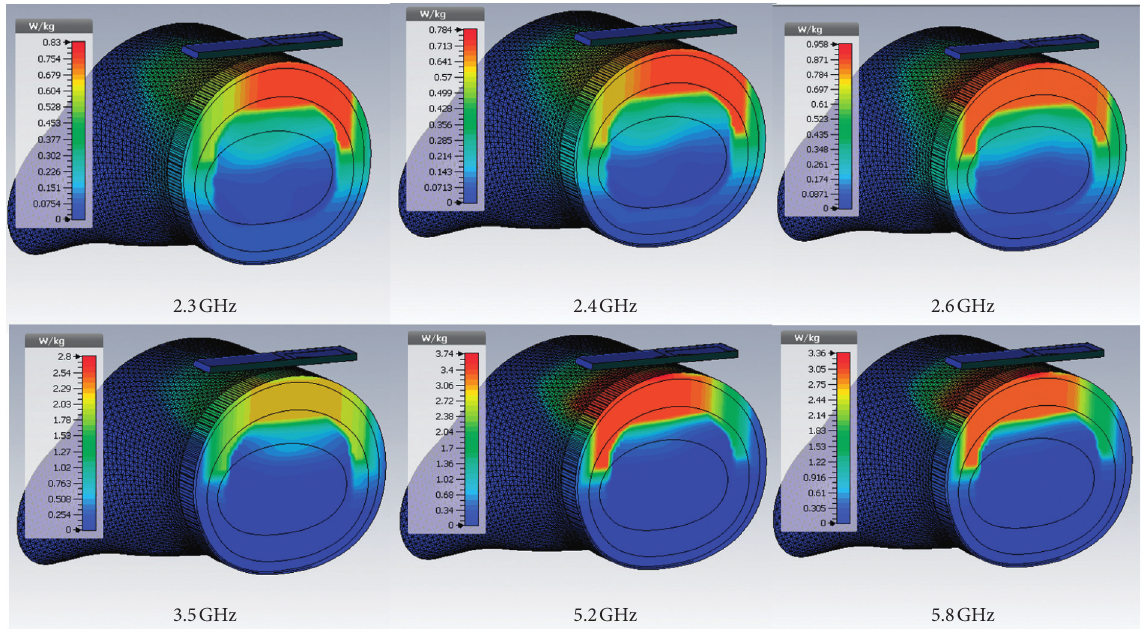
Figure 16: SAR (W/kg) distribution averaged over 10g inside the hand wrist, for a spacing d � 2mm.